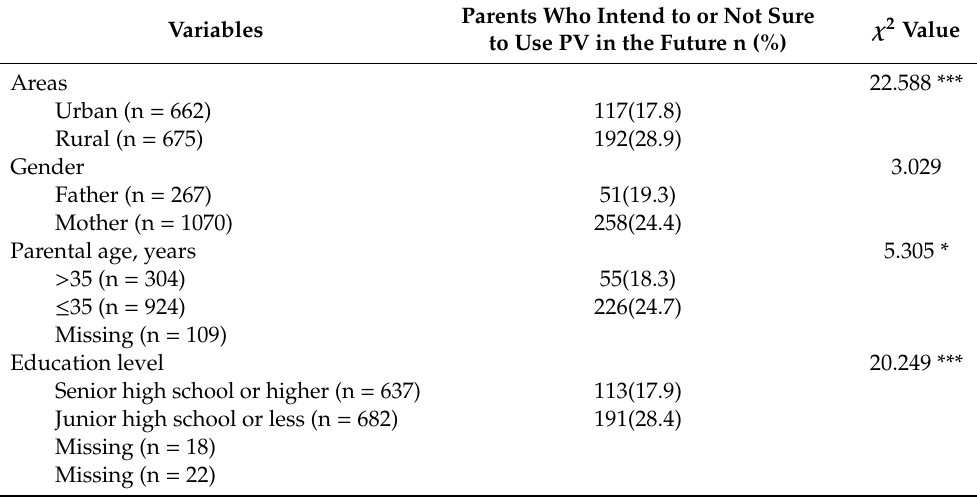
Table 1. Respondents’ demographic characteristics and bi-variable associations with their intentions to use physical violence (PV) in the